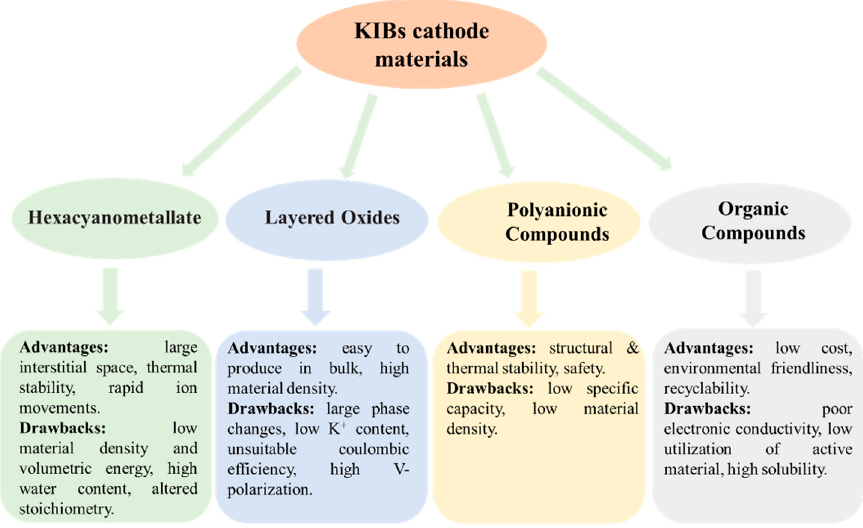
Figure 2. Advantages/drawbacks of different cathode systems for KIBs.